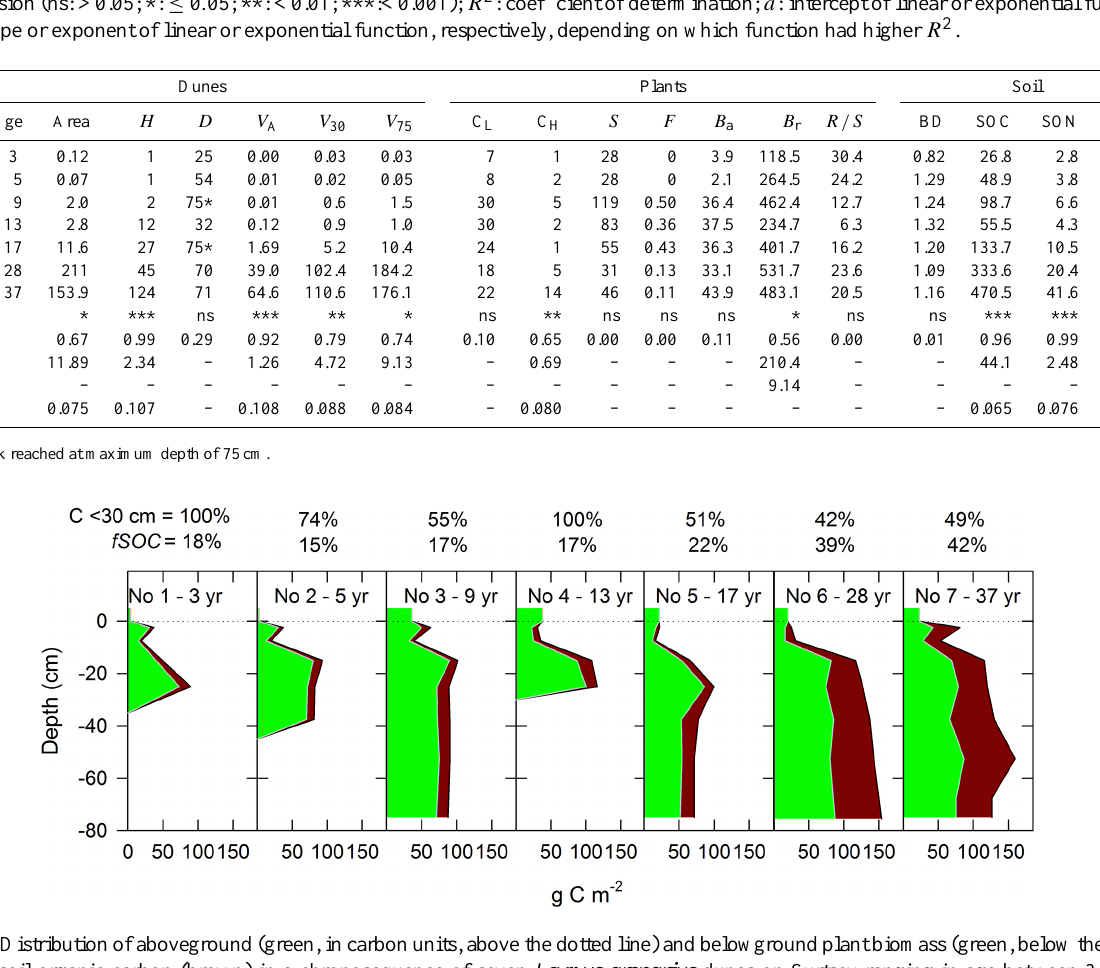
Table 1. Age (years) of the Leymus arenarius colonies/dunes, dune area (m 2 ), dune aboveground height ( H ; cm), mean depth to bedrock under the colony ( D , cm), aboveground dune volume ( V A ; m 3 ), dune volume to 30cm depth ( V 30 ; m 3 ), dune volume to 75cm depth or less if it had shallower depth limit ( V 75 ; m 3 ), Leymus cover (C L ; %), Honckenya cover (C H ; %), shoot density ( S ; nom − 2 ), flowering stems ( F ; no m − 2 ), aboveground biomass carbon ( B a ; gCm − 2 ), root biomass carbon ( B r ; gCm − 2 ), root/shoot ratio ( R/S ), mean soil bulk density (BD,